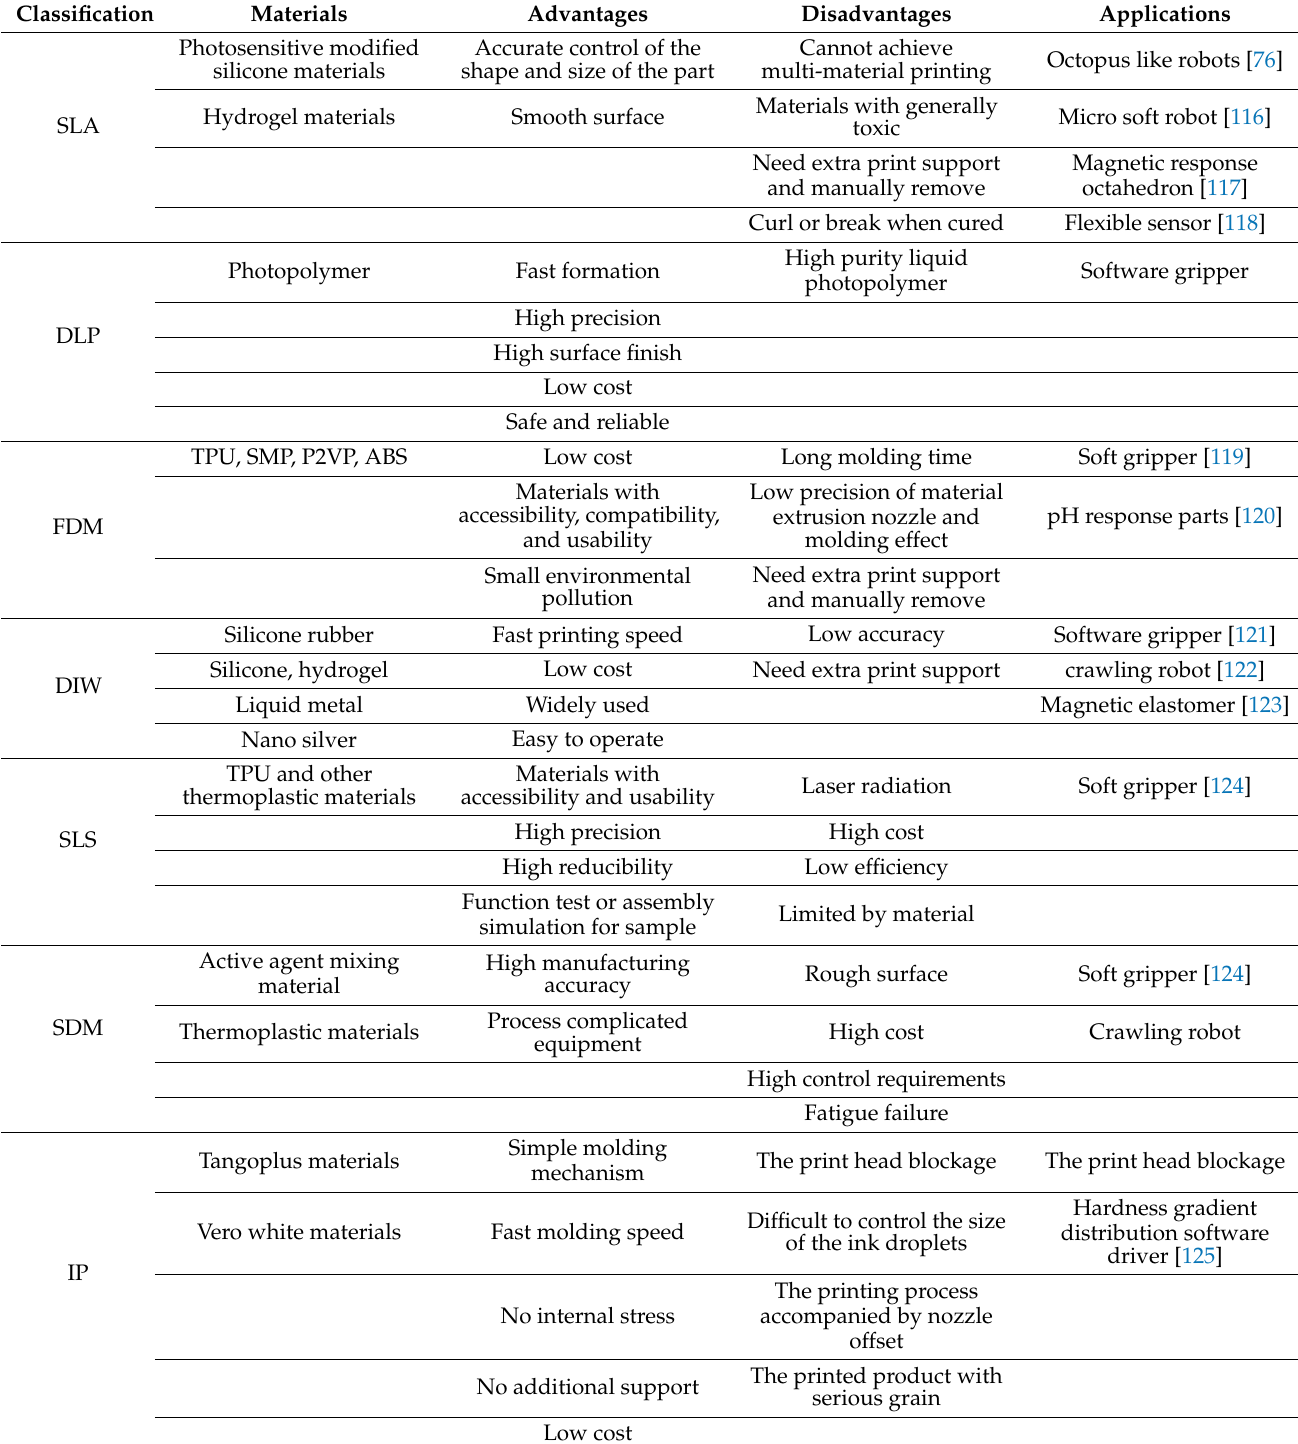
Table 3. Materials, advantages, disadvantages, and applications of different 3D printing manufactur- ing